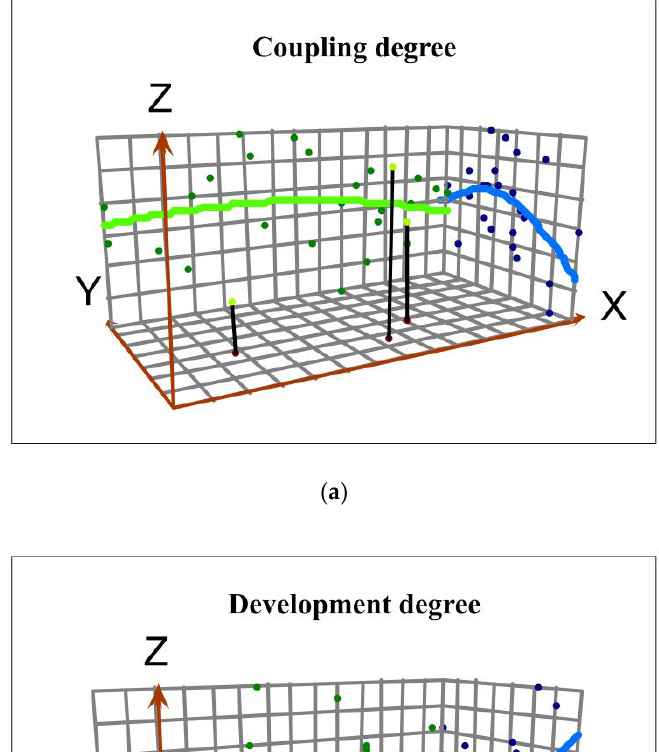
Figure 3. Spatial distribution of the coupling coordination relationship between household liveli- hood efficiency and land use in different regions (districts and counties). Coupling degree ( a ), de- velopment degree ( b ), coupling coordination degree ( c ).